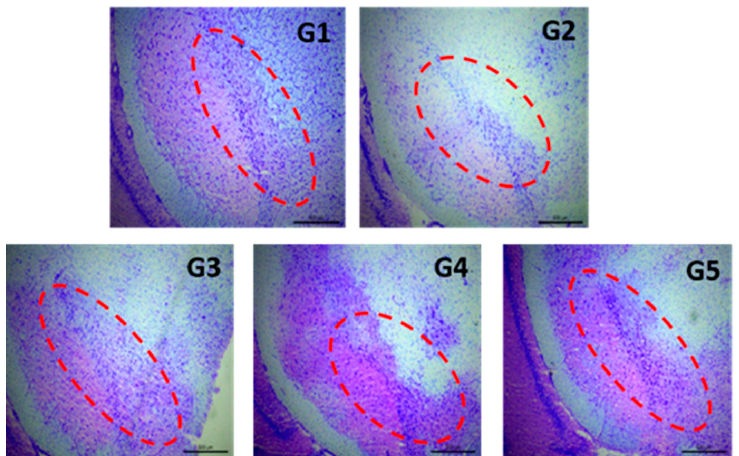
Figure 4. Representative Nissl-staining (cresyl violet) of nigral neurons from brain sections (substantia nigra, 30 µ m) corresponding to all animal groups. Control group (G1); RT-treated control group (G2); RT-treated animals also receiving formulation MP-TC4 (G3), formulation NP-TC3 (G4), and TC in saline (G5). RT (rotenone), TC (tolcapone).